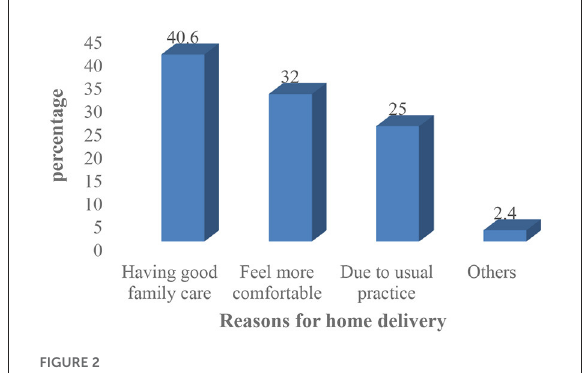
FIGURE2 Reasons for home delivery in Mandura district, Benishangul Gumuz, Ethiopia, 2020 ( n =